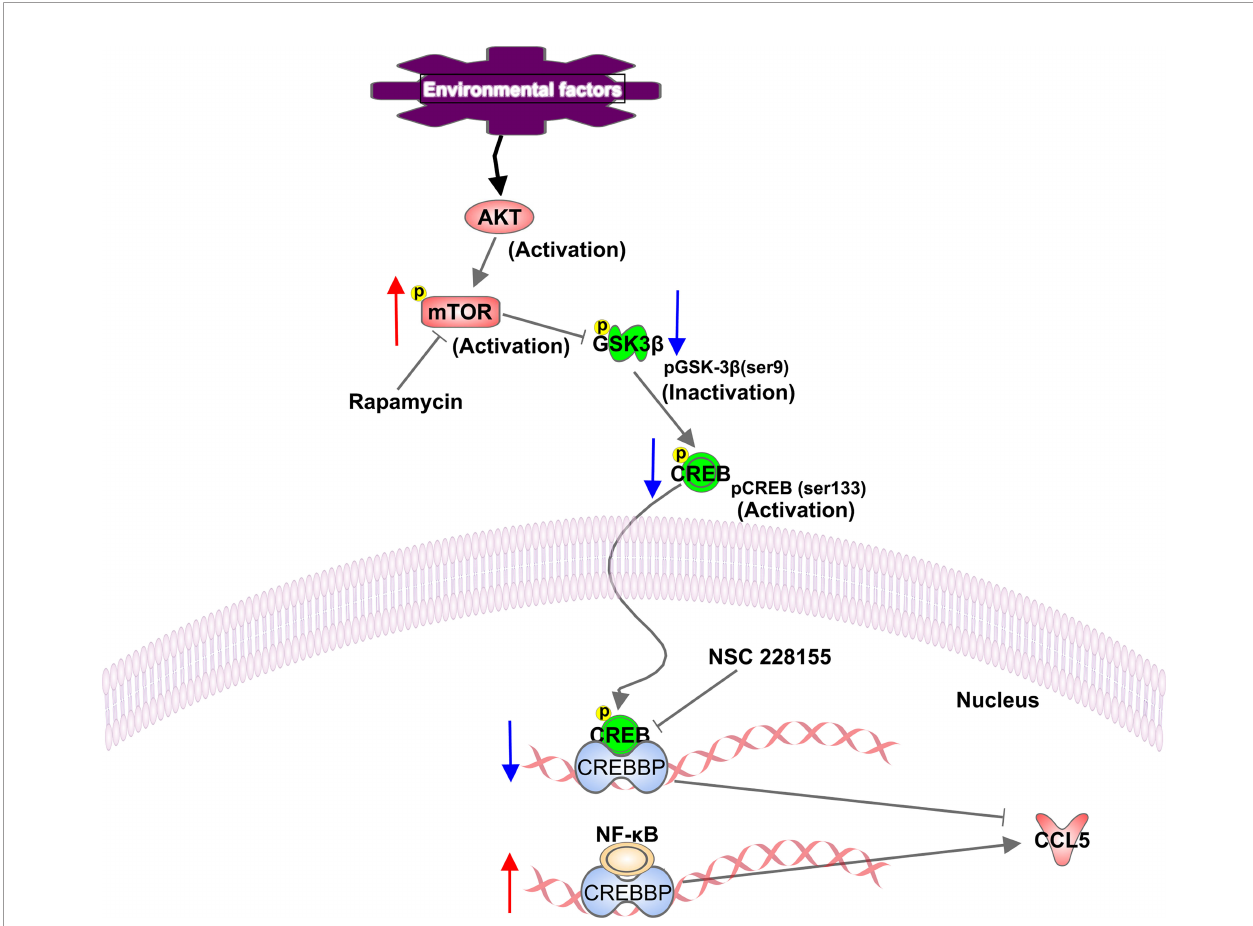
FIGURE 7 | Schematic representation of a proposed mechanism of CCL5 release involving activation of the mTOR pathway. In our study, mTOR signaling is activated in ASD patients. Phosphorylated mTOR at serine residue 2448 down-regulates the phosphorylation of GSK-3 b at Ser9, and contributes to the reduction in phosphorylation of CREB at Ser133, which leads to the decreased binding of CREB to CREBBP. Thereby more available CREBBP could bind with NF- k B, which promotes the CCL5 production. The up-regulation and down-regulation of the component involved in the signaling pathway are indicated with an up arrow (red) and a down arrow (blue),